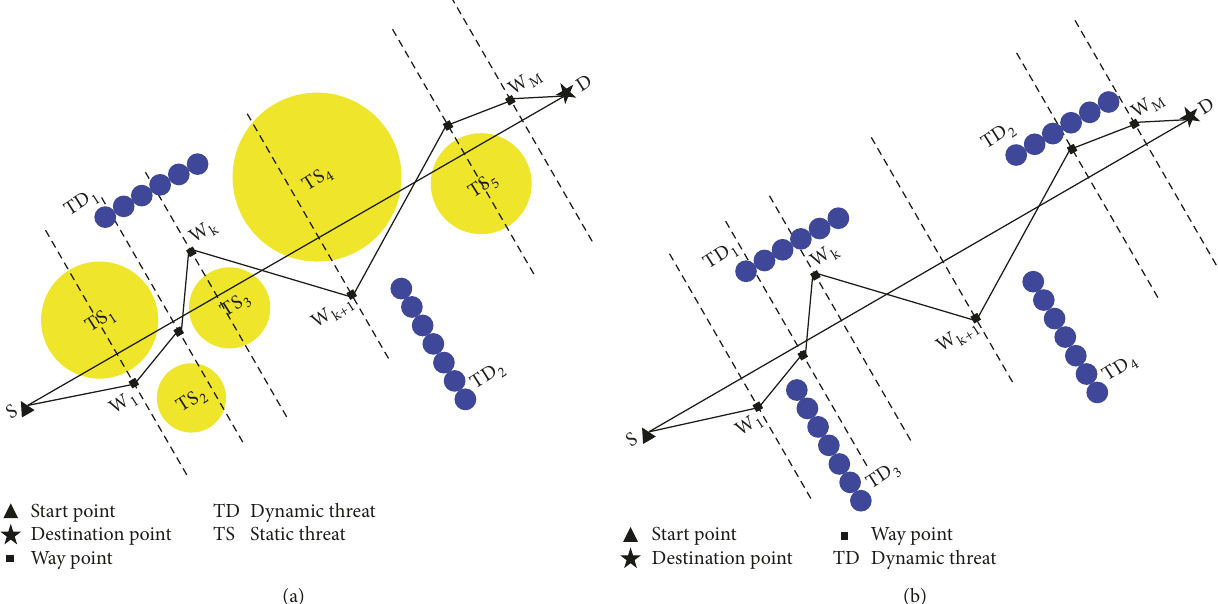
Figure 1: Typical UAV path planning model. (a) contains both mobile threats and static threats while (b) only contains the mobile